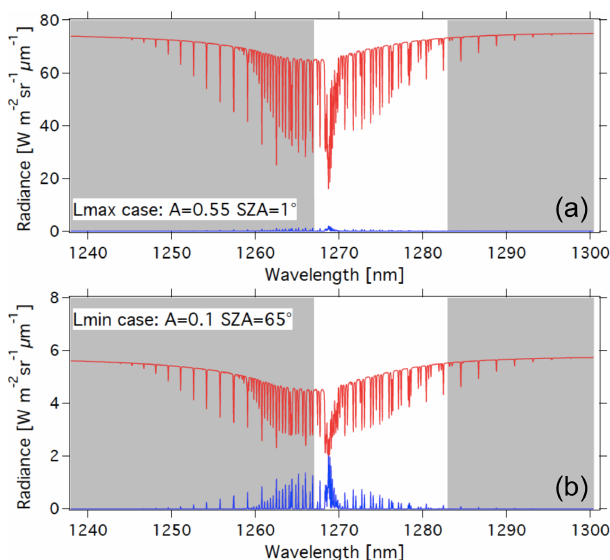
Figure 15. Airglow (blue) and scattered sunlight (red) absolute intensities and radiances (in Wm − 2 sr − 1 µm − 1 ) for two cases: (a) high albedo ( A = 0 . 55) and almost sub-solar SZA of 1 ◦ (re- ferred to as the Lmax case (maximum luminance for instrument SNR estimates) and (b) low albedo ( A = 0 . 1) and high SZA of 65 ◦ (referred as the Lmin case for SNR estimates for minimum lumi- nance). The depression on the continuum of reflected sunlight is due to the O 2 CIA (now included in HITRAN 2016; Gordon et al., 2017). Water vapour absorption lines, which would be on the right part of the spectra, are not represented here. The white area corre- sponds to the MicroCarb wavelength